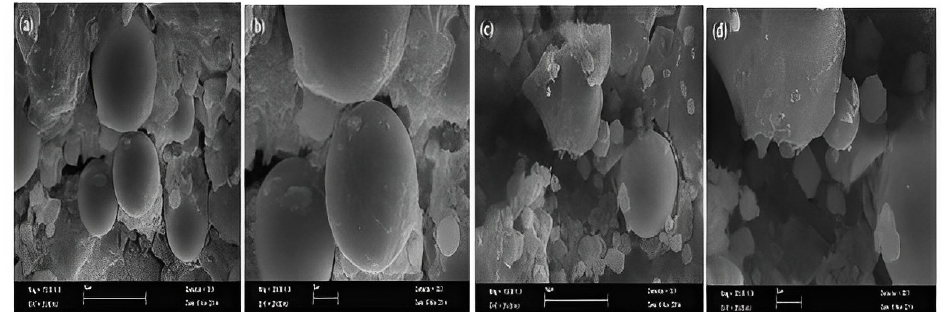
Figure 17. SEM analysis of 28-day geopolymer mortar [106]. (Reprinted with permission from the publisher, Elsevier; License No. 5471711440902).